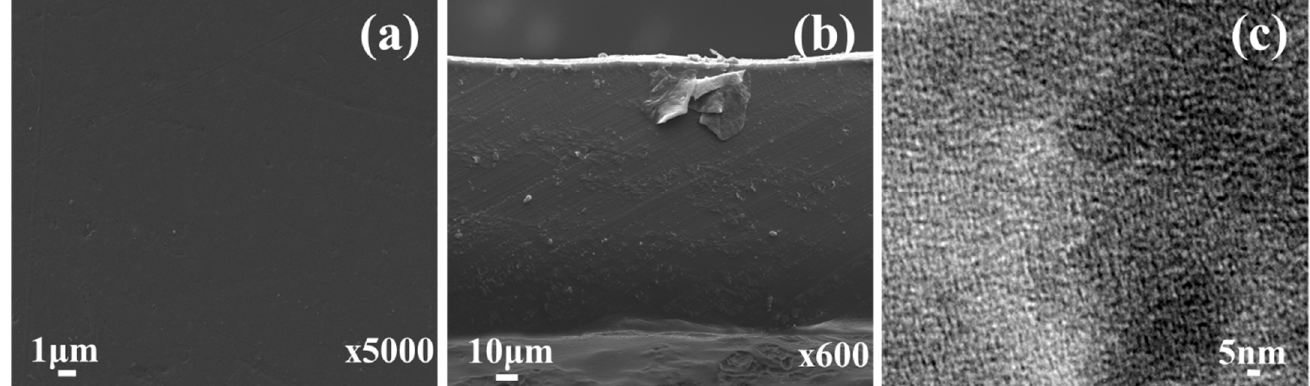
Figure 4. Microscopy images of the as-prepared PVIB-10 membrane: ( a ) SEM image of the membrane surface, ( b ) SEM image of the membrane cross-sectional morphology and ( c ) TEM image showing the nano-phase separated morphology of the PVIB-10 membrane.